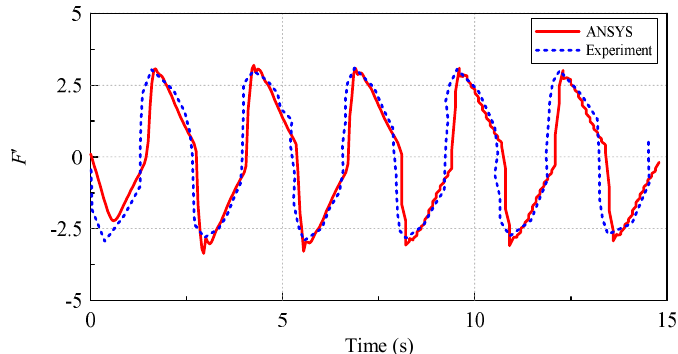
Figure 9. The comparison of the forces acting on the tank wall; solid line: ANSYS results; dashed line: experimental measurements (Krabbenhøft, 2011) [20]. Tank length = 0.59 m, water depth = 0.02 m, the exciting amplitude = 0.02 m, and the exciting frequency = 2.36 rad/s.